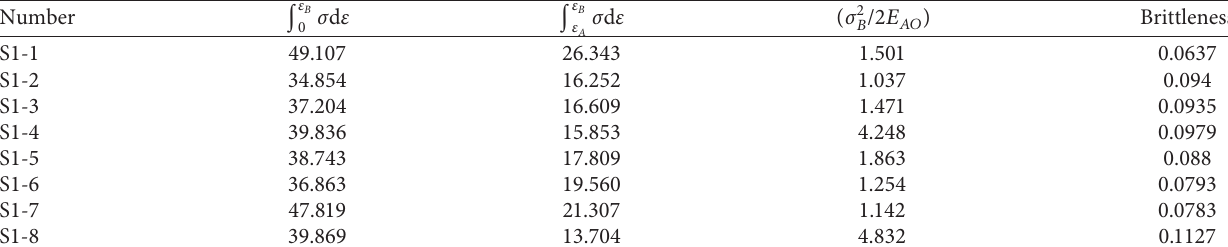
Figure 11: A geometric model for brittleness calculation [20]. Table 4: Brittleness calculation table of deep